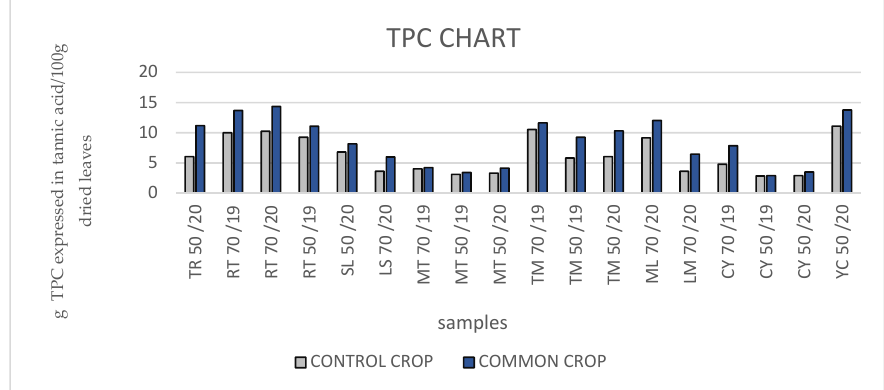
Figure 19. Graphic representation of total phenolic content. As we highlight in the figures for the each Plant product (Figure 20a–j) there is a statistically significant interaction ( p value < 0.05) between the effects of Compound and Sample on value of concentration except four cases: MT, TM, ML and YC. Simple main effects analysis showed that the common crop is statistically different from control crop ( p value < 0.05), except YC and between FL, PCA’s and TPC there are statistical differences, except TR, TM, ML and YC where PCA’s and TPC behave similarly statistically.